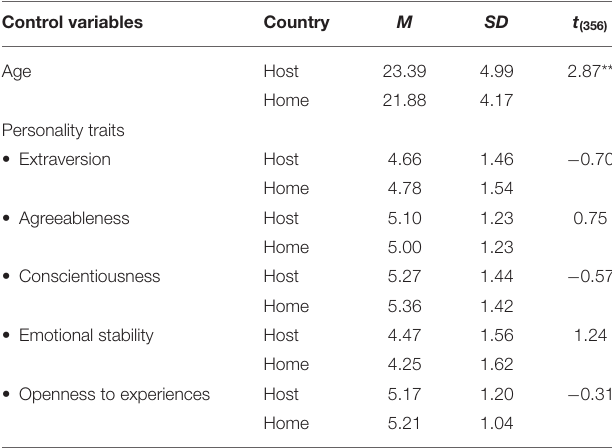
TABLE 2 | Age and personality differences between students staying in the host ( N = 236) vs. home ( N = 121)